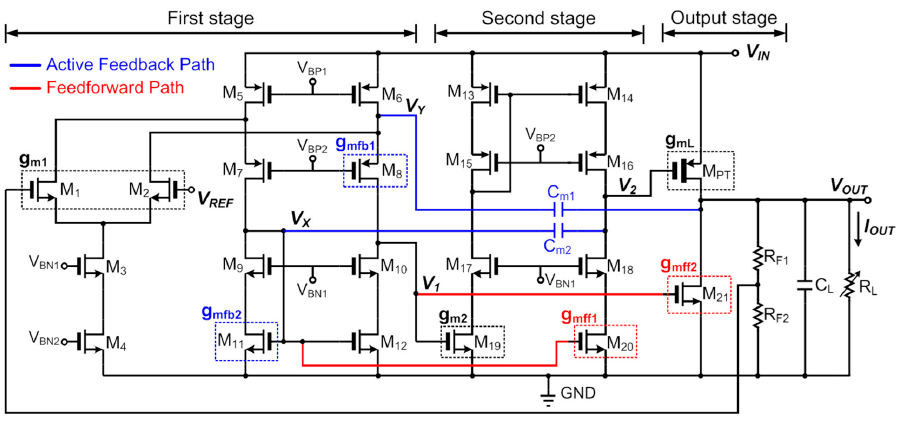
Figure 8. Schematic of three-stage OCL-LDO regulator employing the proposed AFCFC.